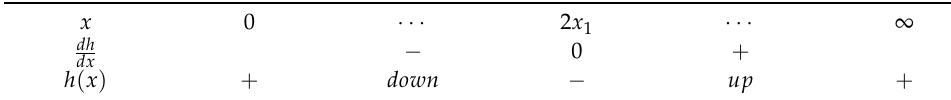
Table 4. The full derivative sign chart of h ( x